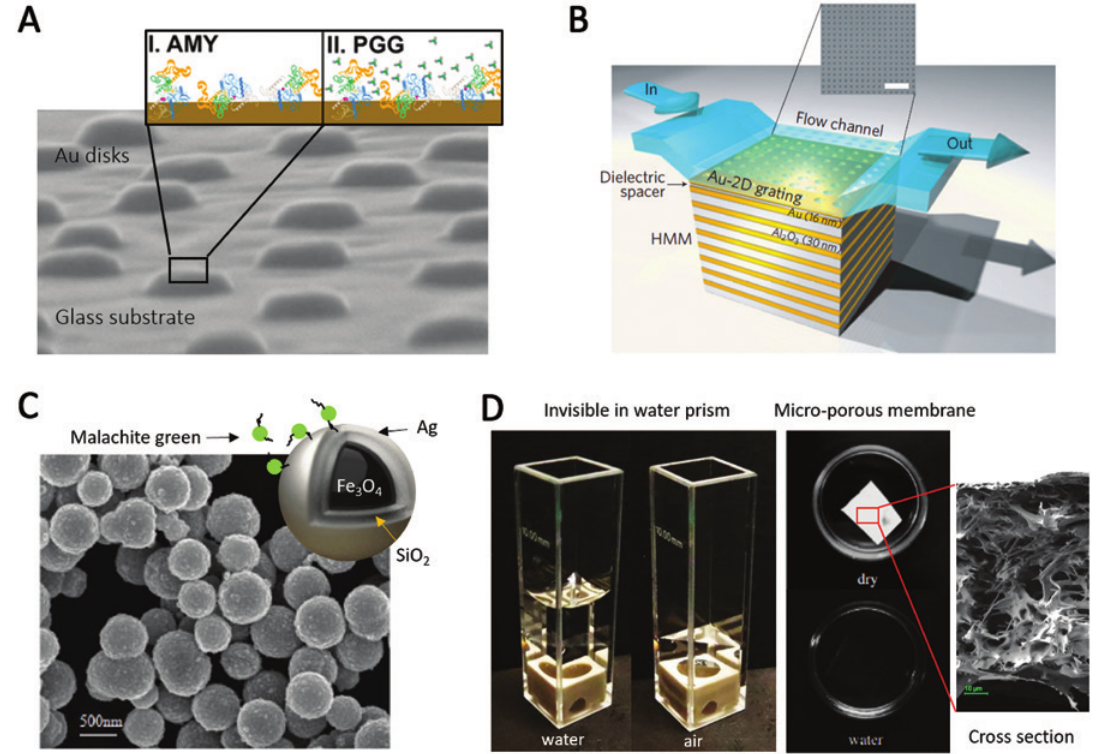
Figure 3: Substrates for small-molecule